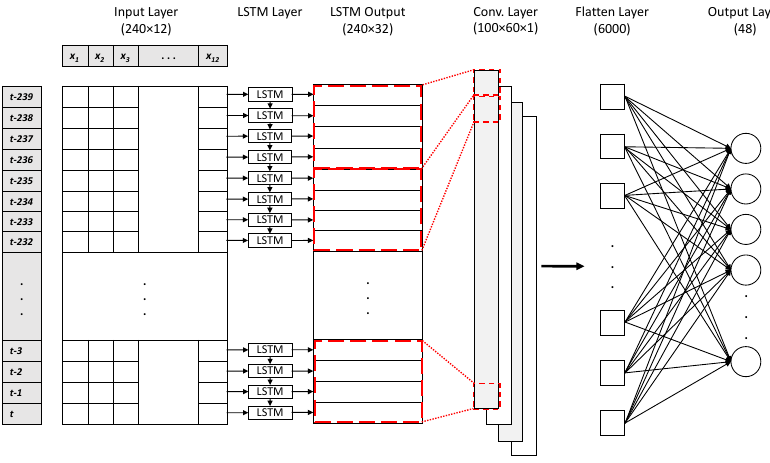
Figure 4. LSTM-CNN model architecture with filter and stride size of 4.